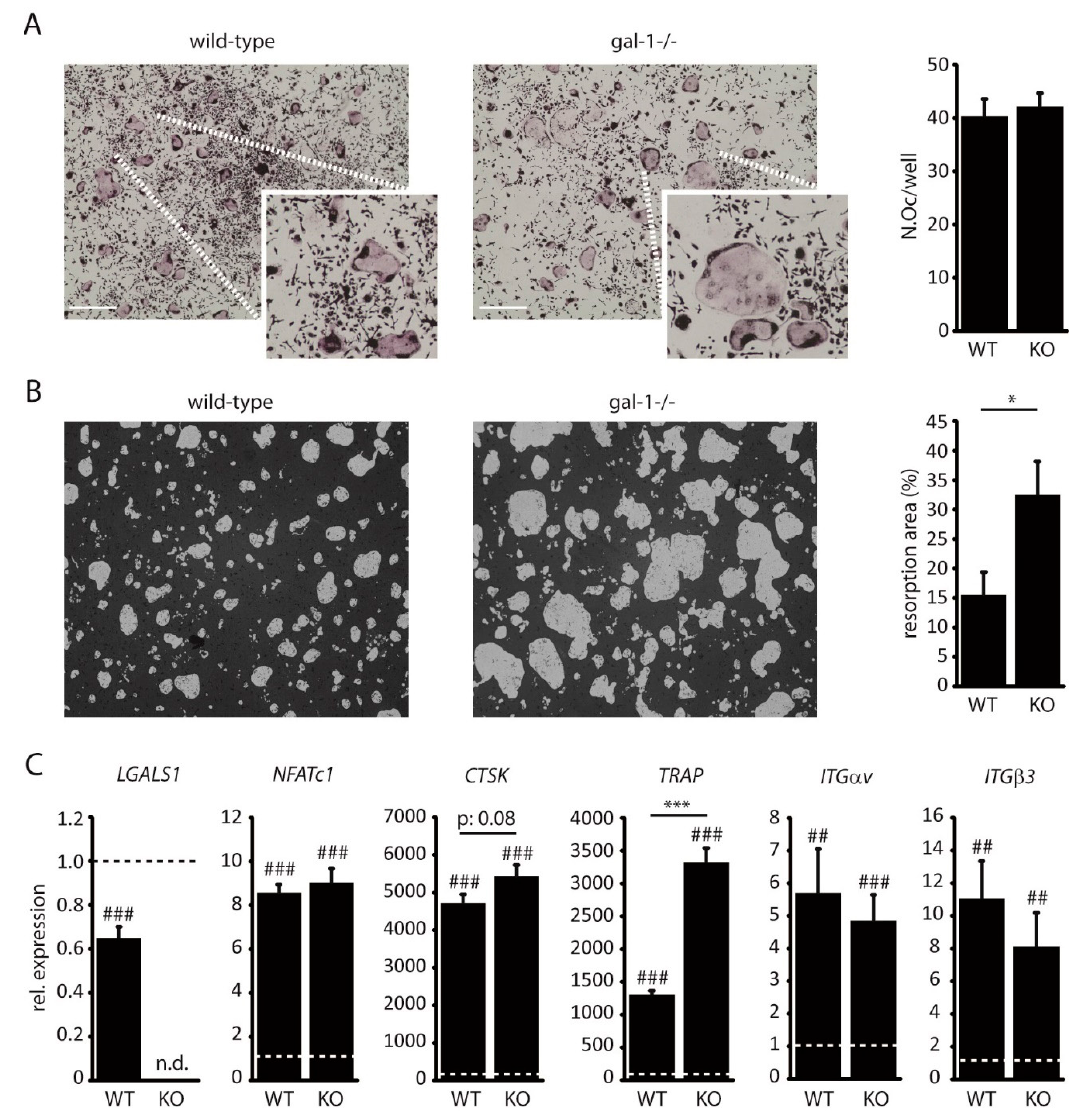
Figure 2. Loss of gal-1 enhances bone matrix resorption by osteoclasts. ( A ) Representative images of TRAP-stained primary (left) wild-type and (centre) gal-1 − / − -derived osteoclast cultures. Quantification (right) of osteoclast number per well. (scale: 100 µm) ( B ) Resorbed matrix and quantification of the resorbed area. ( C ) Real-time PCR of osteoclast differentiation markers in mature osteoclasts derived from wild-type and gal-1 − / − mice versus monocyte cultures (dotted line) (n.d.: not detected). From left to right: galectin-1 (LGALS1), NFATc1, cathepsin K (CTSK), TRAP, Integrin α v (ITG α v) and integrin β 3 (ITG β 3). Significance level versus monocyte cultures. All data are representative of three ( n = 3) biologically independent experiments and represented as mean +/ − standard error. ## p < 0.05; ### p < 0.001; * p < 0.05; *** p < 0.001.